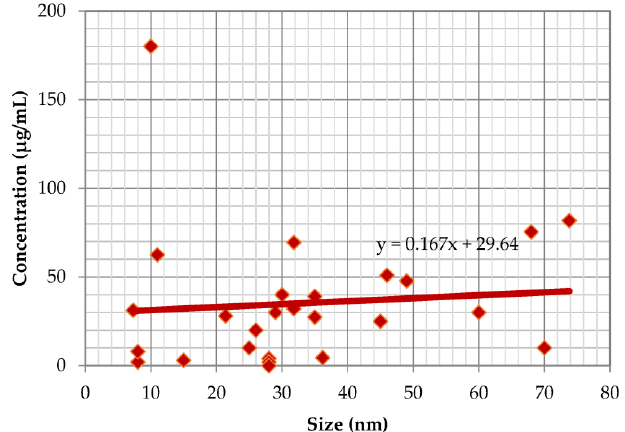
Figure 2. The correlation between the average size of the plant-mediated syntheses of metallic nanoparticles and cytotoxicity at 48 h of exposure. Plant metallic nanoparticles; Trendline.